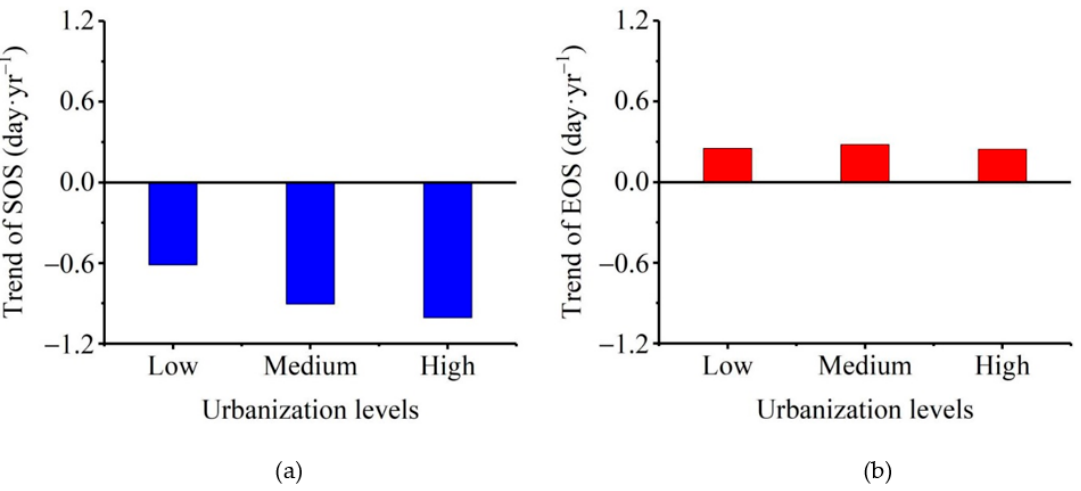
Figure 4. Variability of vegetation phenology in the Dongting Lake basin across different urbanization levels. ( a ) start of the growing season (SOS) and ( b ) end of the growing season (EOS).